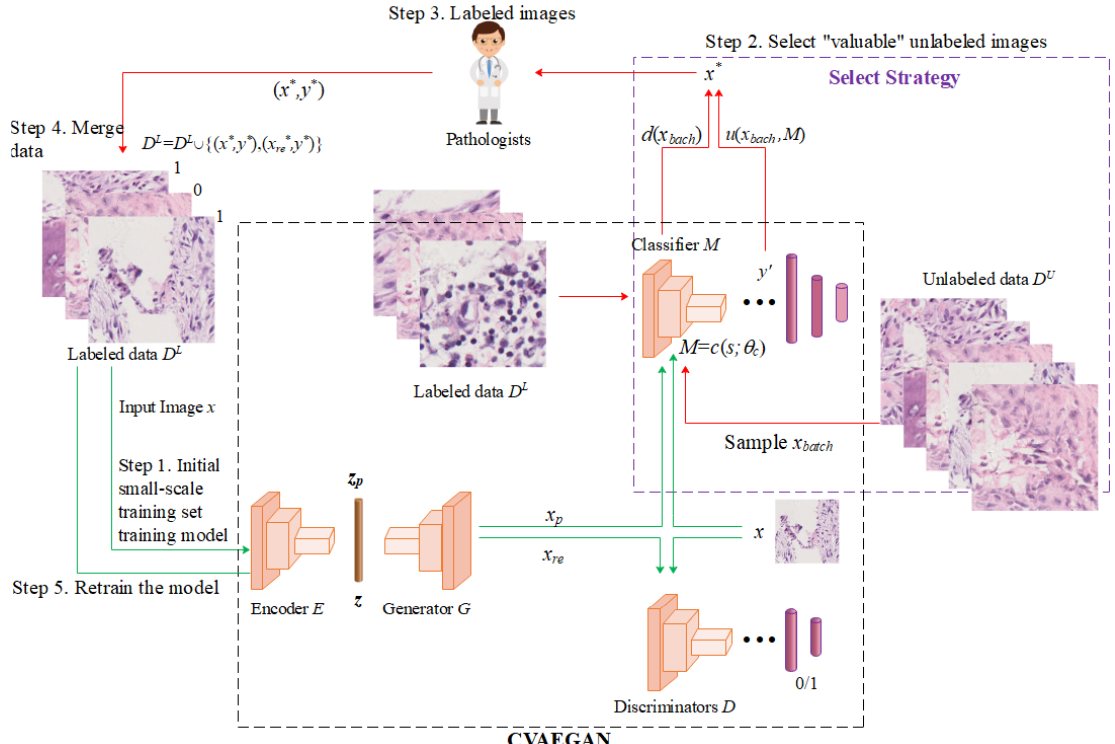
Figure 2. The detailed structure of the proposed deep active-learning framework. The boxes in the figure represent models, and the ellipses represent database entities. Oracle is usually a human expert. The arrows represent the data flow, the green arrows are the training process, and the red arrows are the filtering process. 𝐸 , 𝐺 , 𝐷 , and ℳ form the CVAEGAN model.